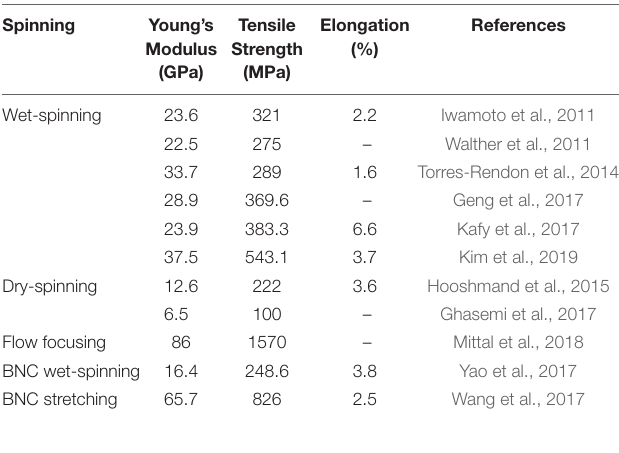
TABLE 2 | Mechanical properties of different cellulose nanofiber